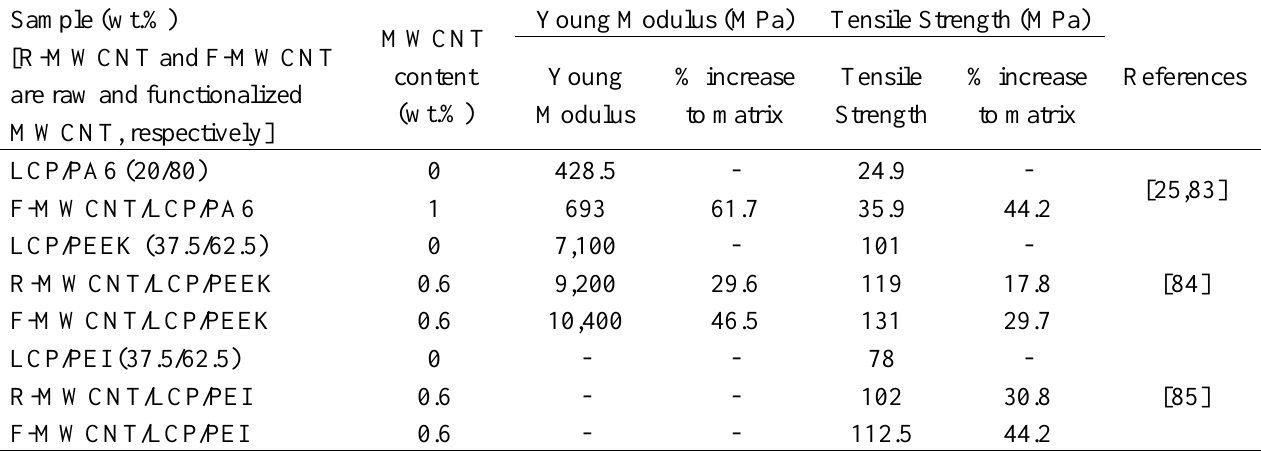
Figure 6. SEM images of ( a ) TLCP/PA6 blend and ( b ) 1 wt.%